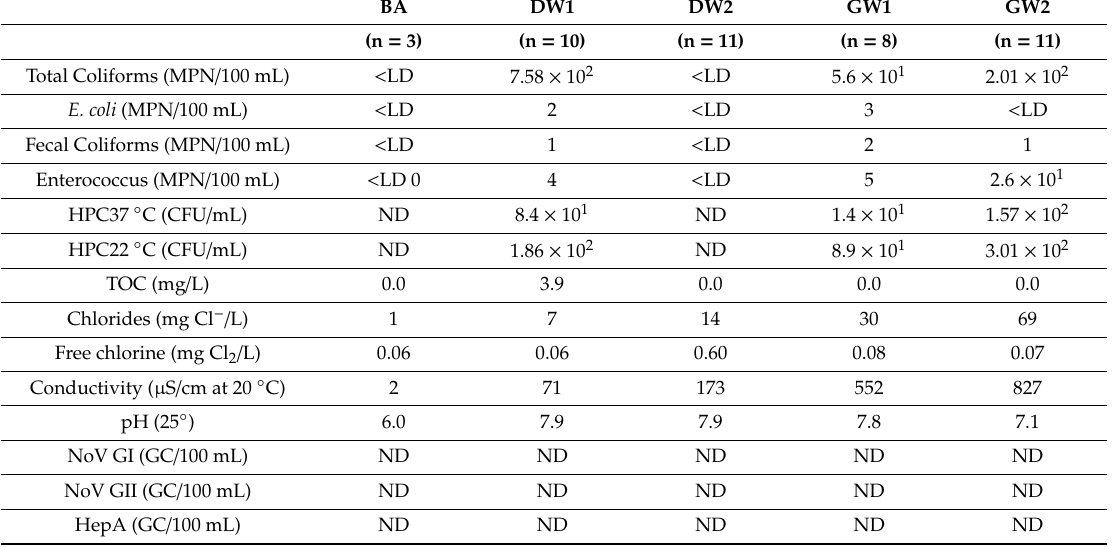
Table 1. Microbiological, physical, and chemical results (median) for blank assays (BA), superficial water intended for drinking water production (DW1), drinking water from Lisbon’s supply system (DW2), and underground water samples collected at two di ff erent sites in Lisbon (GW1 and GW2). MNP—Most Probable Number, CFU—Colony Forming Units, GC—Genomic Copies. ND—Not detected. n = total analyzed samples. LD (limit of detection) = 1 MPN / 100